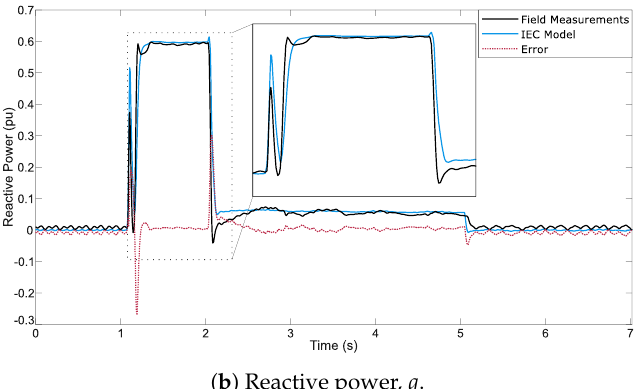
Figure 5. Active and reactive power comparison between the field measurements and the simulation responses of a DFIG Siemens Gamesa WT under a voltage dip. TC1, WT operating at full load conditions.